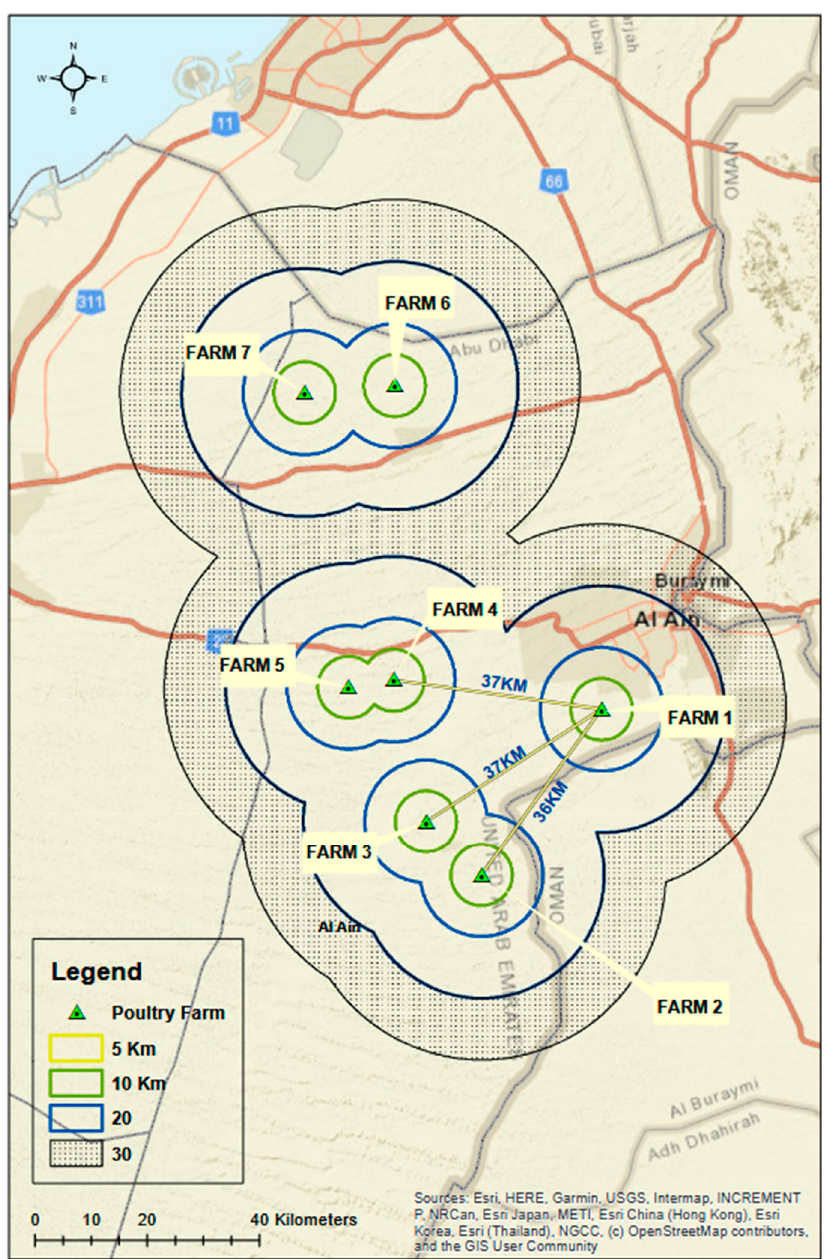
Figure 1. Map showing the location of the seven FAdV infected farms in Al Ain region, Abu Dhabi, UAE. The distance between the infected farms were shown in kilometers.